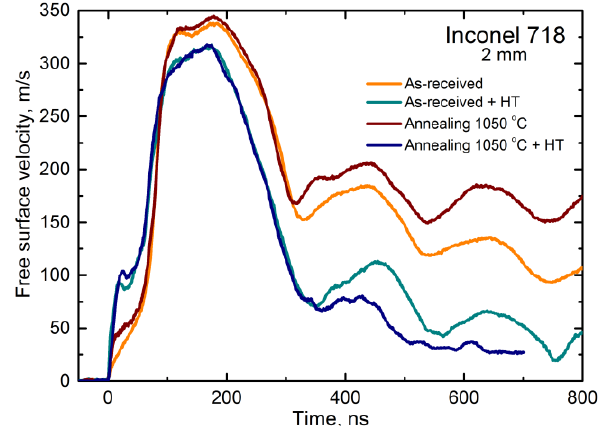
Figure 3. Velocity histories of the superalloy Inconel 718 samples of 2 mm in thickness after different heat treatment (according to regimes 1, 3, 5, 7 of Table 2).